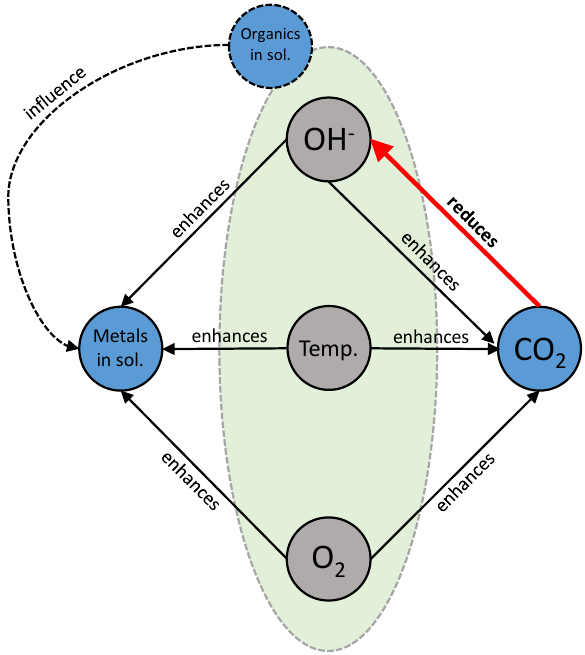
Figure 16. The influence of the leaching conditions on the (intermediate) products.